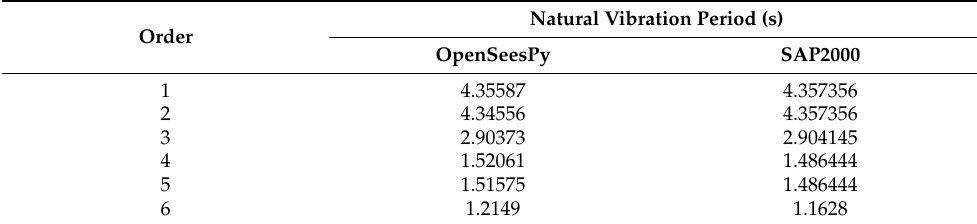
Table 4. Modal analysis results.